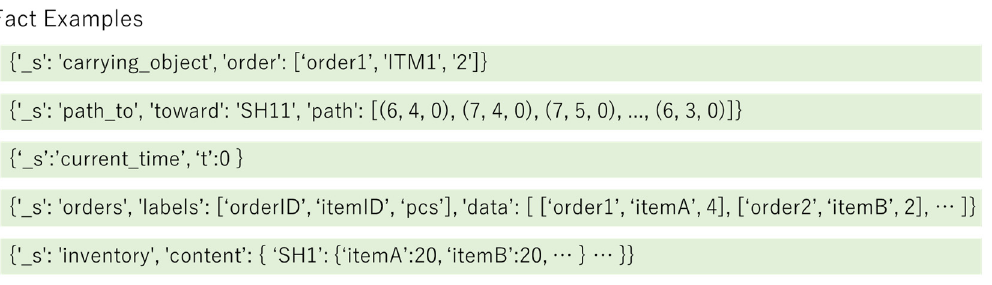
Figure 5. Fact of map information stored in spatial-temporal agent (example). The overview of the messaging sequence of agents in simulation models is shown in Figure 6. In every time frame, the spatial-temporal agent first broadcasts the performative of tick_start to the simulation agents. Simulation agents then make decisions at the current time frame by evaluating rules, executing actions, and/or exchanging messages (e.g., messages with handover performative, pick, etc.). Next, simulation agents send messages with the move_request performative (not applicable if the simulation agent does not have a physical location) to move to the next location in the next time frame. The spatial-temporal agent then evaluates the requests and replies to the messages with move_request_accepted performative to grant the requests. If the move_request messages conflict with the next physical location or the next physical location is unacceptable (e.g., the requested location is a wall), the spatial-temporal agent replies with move_request_rejected performatives. The simulation agents that received the messages with move_request_rejected then make the decisions again and sends the move_request until they are accepted. This procedure repeats in every time frame.